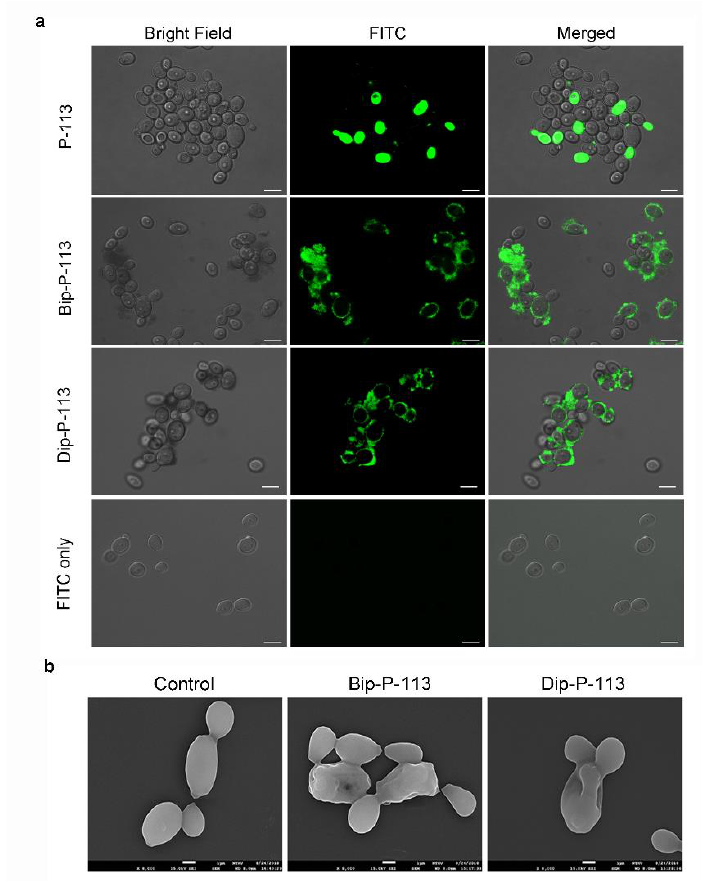
Figure 10. ( a ) Localizations of FITC peptides in in Candida albicans . Confocal microscopy was used to visualize 10 7 CFU / mL of C. albicans were incubated at 28 ◦ C for 5 min with 50 µ M of FITC-conjugated peptides. The left panels show a bright field, the middle panels show FITC images, and the right panels show merged images. The bar corresponds to 5 µ m. ( b ) Scanning electron microscopic micrographs of C. albicans only as a control and treated with Bip-P-113 and Dip-P-113 peptides (Bip = β -(4,4 β -biphenyl)alanine; Dip = β -diphenylalanine). Each figure is magnified ×8000.